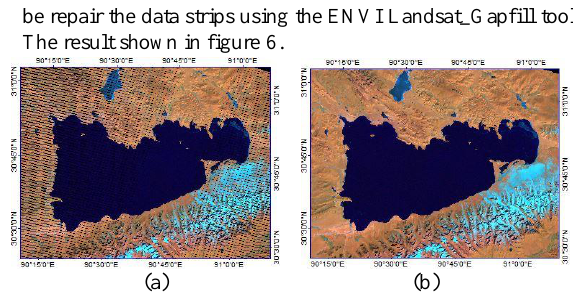
Figure 6. Before and after the Strip repair ((a) before, (b) after)